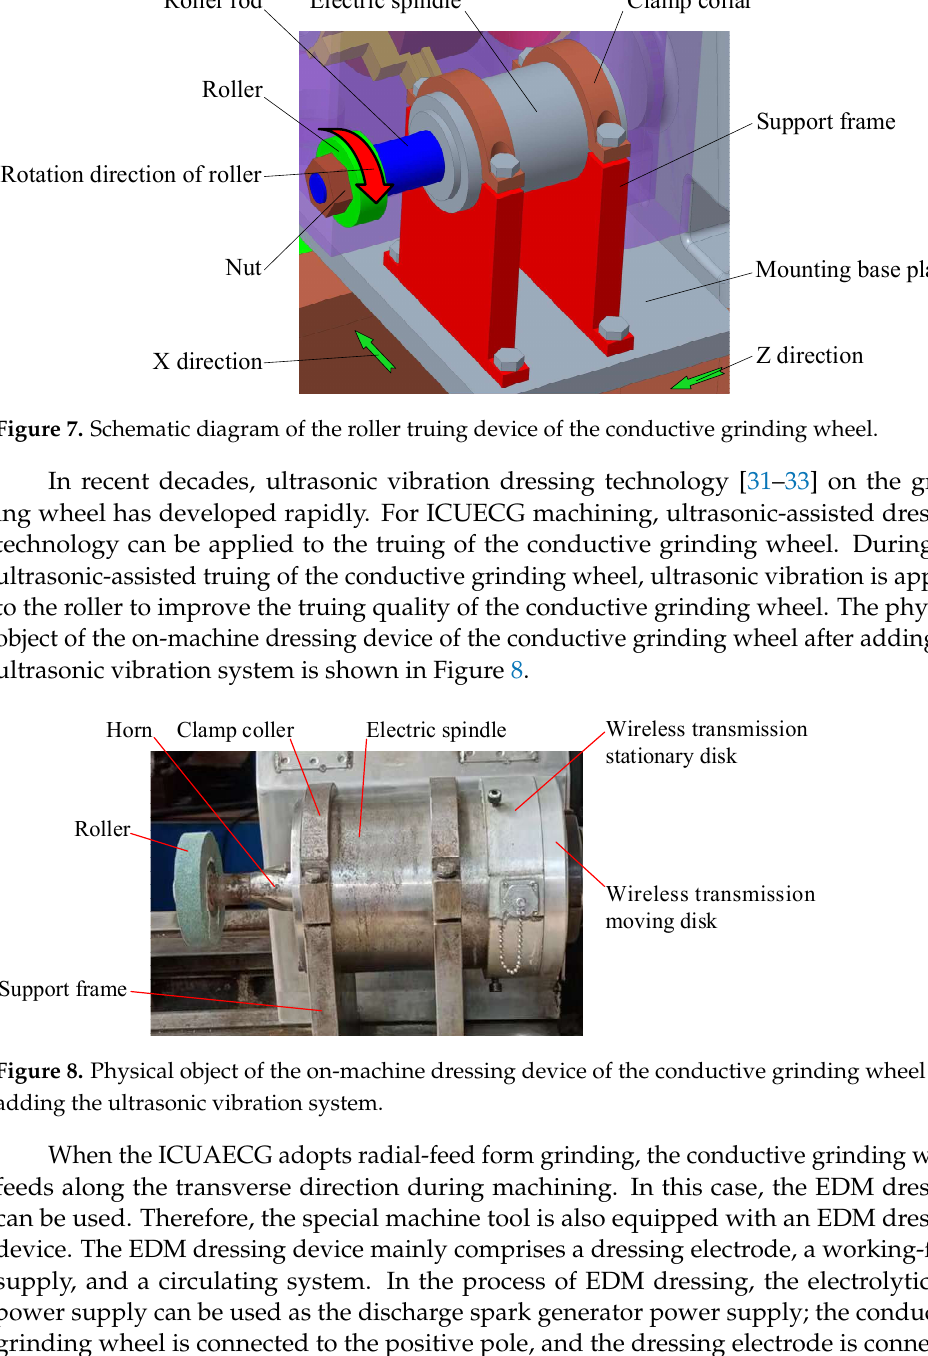
Figure 8. Physical object of the on-machine dressing device of the conductive grinding wheel after adding the ultrasonic vibration system.